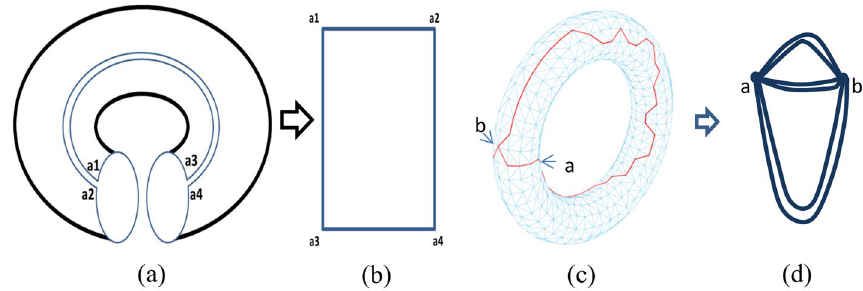
Figure 3. Unwrap the torus into a plane and construct an undirected graph from a cut path.